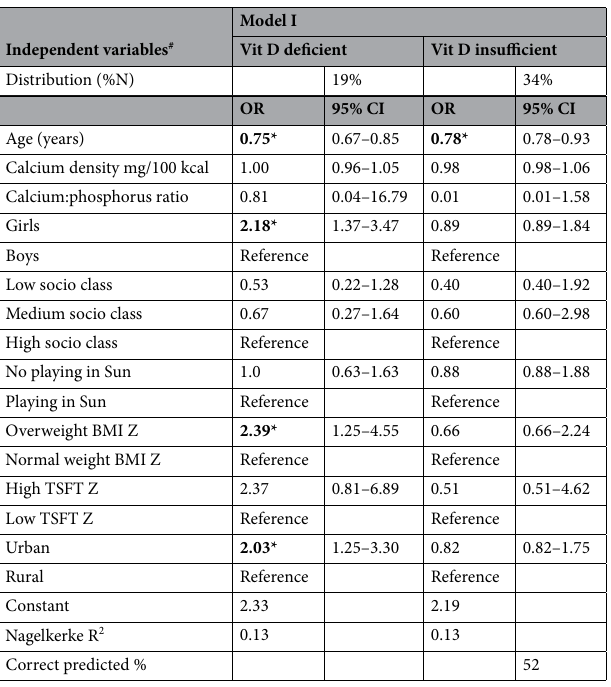
Table 4. Multinomial logistic regression to determine predictors of vitamin D status in subset study population, n = 669 (Model 1: demographic, anthropometric, body composition and lifestyle parameters including urban/rural residence). Significant values are in [bold]. TSFT triceps skin fold thickness, Z Z-scores. Level of Significance—* p < 0.05. # Variables are presented as OR (95%